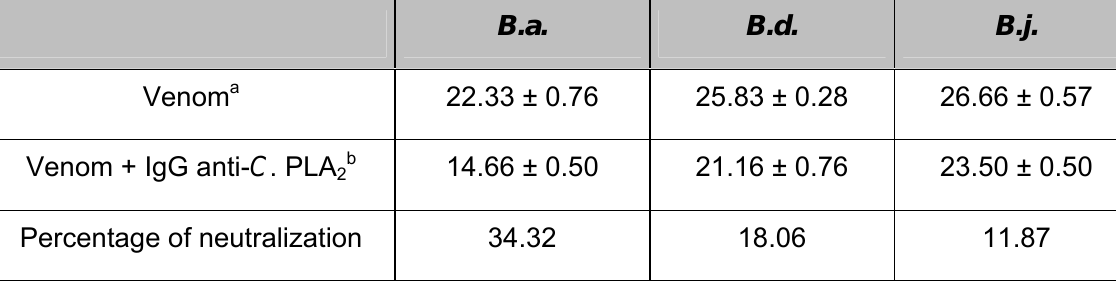
Table 1. Indirect hemolytic activity neutralization